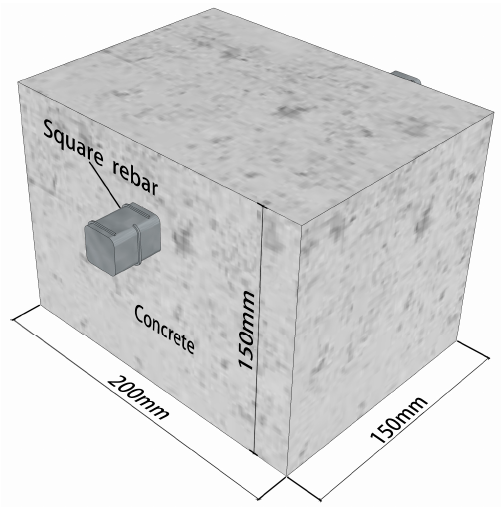
Figure 6. Dimension of the specimen.